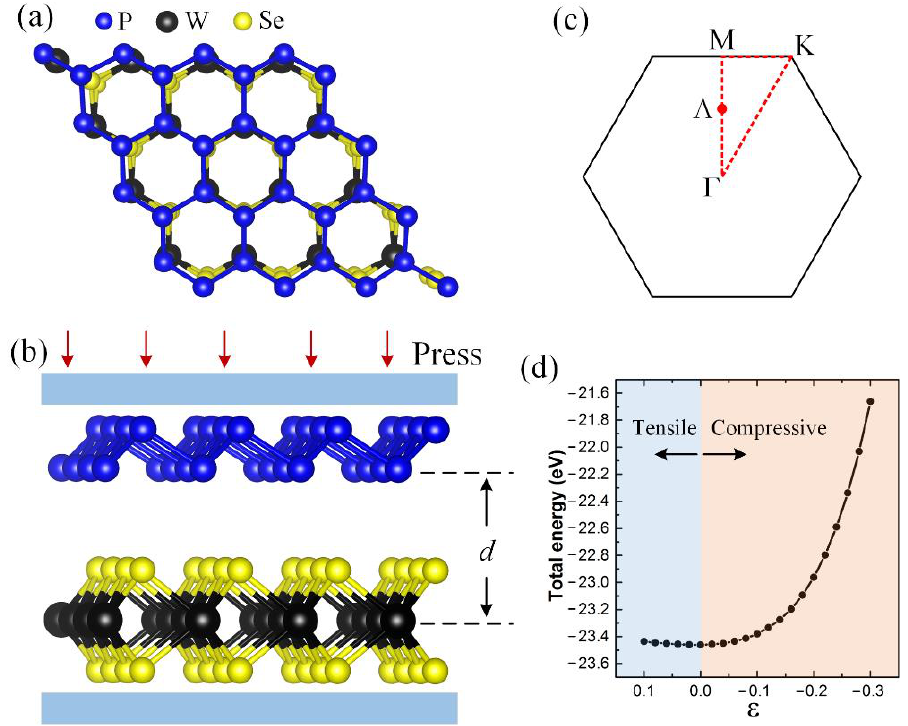
Figure 1. ( a ) The top and ( b ) the side view of BlueP/WSe 2 vdW heterostructure. ( c ) The Brillouin zone with high-symmetry points (M, K, and Γ) and the point Λ (between M and Γ) labeled. ( d ) Evolution of the total energy of BlueP/WSe 2 vdW heterostructure as a function of vertical strain.